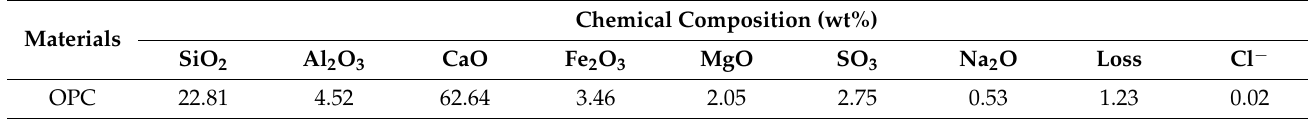
Table 1. Chemical composition of cementitious materials as detected by XRF.